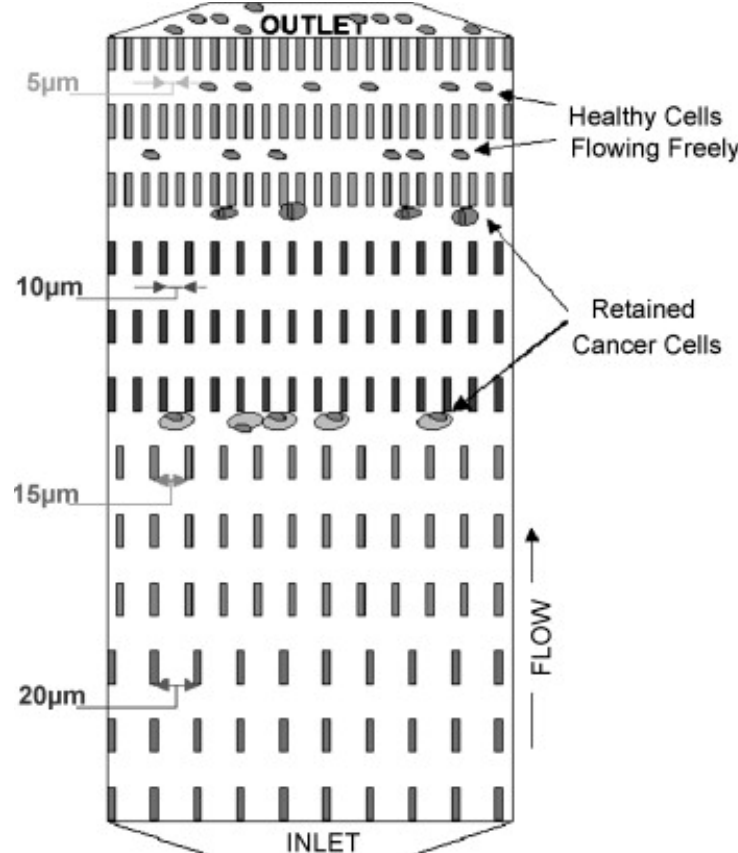
Figure 1. Schematic illustration of the microdevice with successively narrower channels for CTC isolation. Varying channel gap widths (20, 15, 10, and 5 μ m) separate cells based on size and deformability. (Reprinted from [41]).